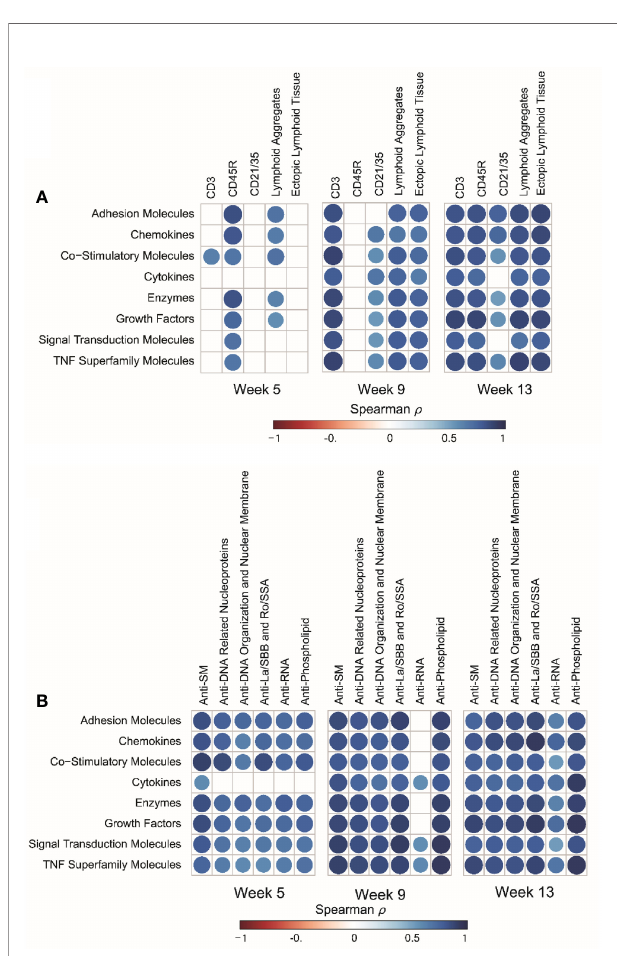
FIGURE 8 | cSiO 2 -induced in fl ammatory proteins in BALF positively correlate with ectopic lymphoid tissue (ELT) development and IgG autoantibody responses. (A) For all cSiO 2 -treated groups, spearman r values were calculated by correlating Z scores for protein groups with markers for ELT development assessed in lung tissues of mice collected 5, 9, or 13wk PI. Markers for ELT development in lung tissues of mice measured as non-continuous histopathology scores of lymphoid aggregates, ectopic lymphoid tissue and the percentage of positively stained tissues (CD3 + , CD45R + , and CD21/35 + ) as described previously (16). (B) For all cSiO 2 -treated groups, Spearman r values were calculated by correlating Z scores with S IgG Ab-score values assessed in BALF of mice collected 5, 9, or 13wk PI as previously reported (36). S Ab-score data calculated as the sum of autoantibodies belonging to a particular category. Signi fi cant correlation values (p ≤ .05) are represented as shaded circles; non-signi fi cant correlations are indicated by blank